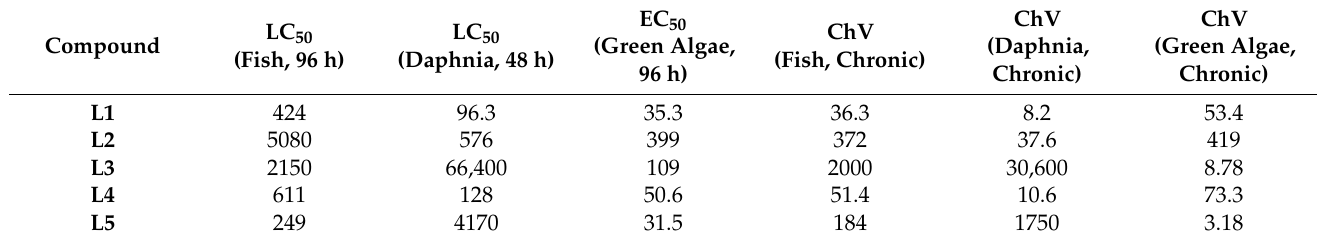
Table 8. Toxicity evaluation of the coumarin-neurotransmitter derivatives (mg L − 1